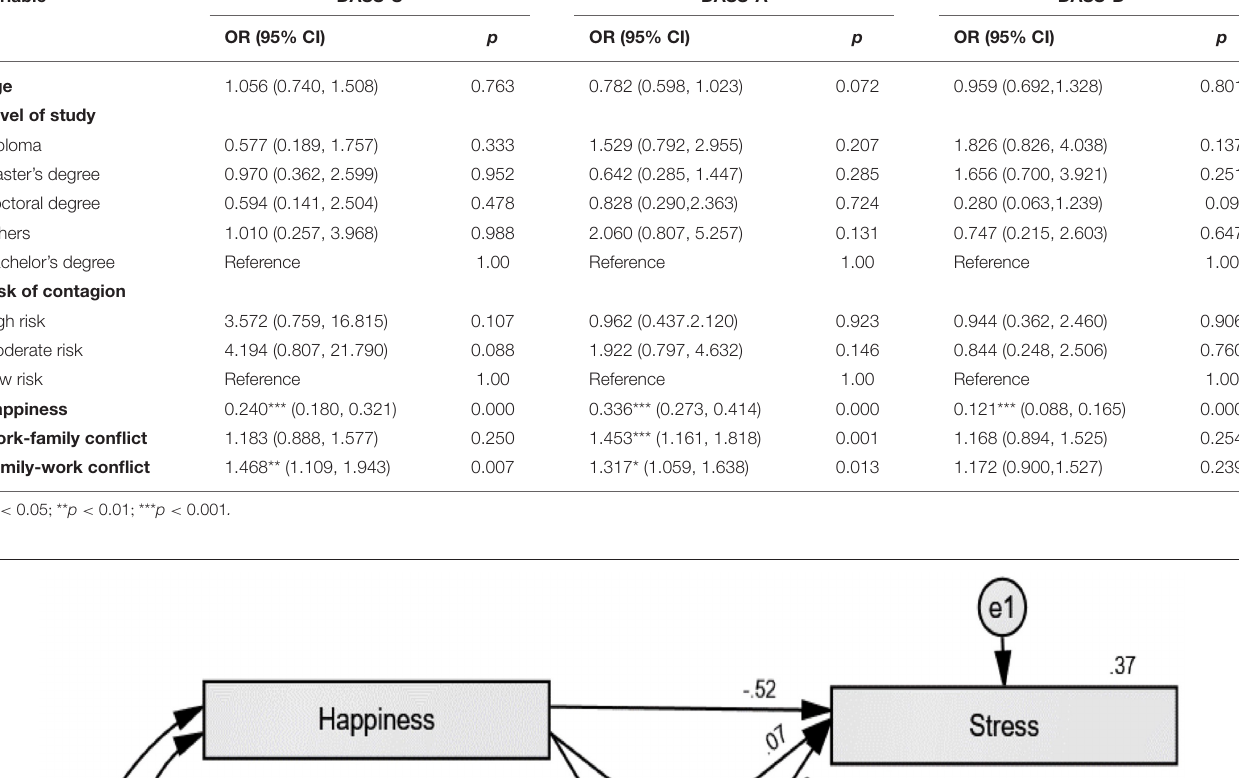
TABLE 7 | Predictors to severe stress ( > 25), anxiety ( > 14), and depression ( > 20) symptoms. Variable